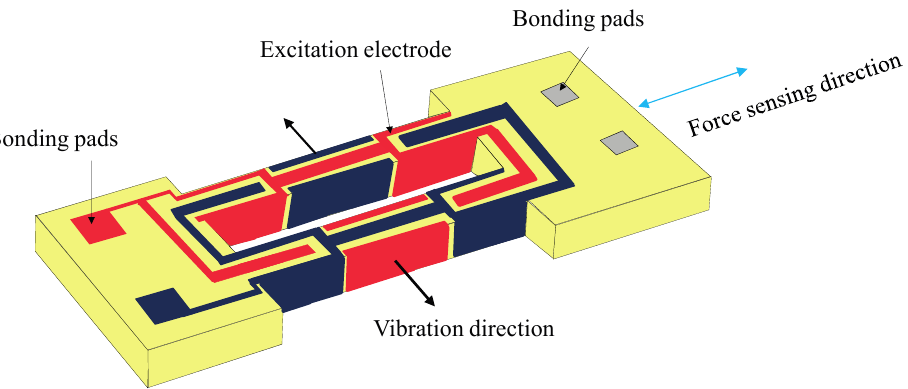
Figure 1. Schematic diagram of double-ended tuning fork and excitation electrode